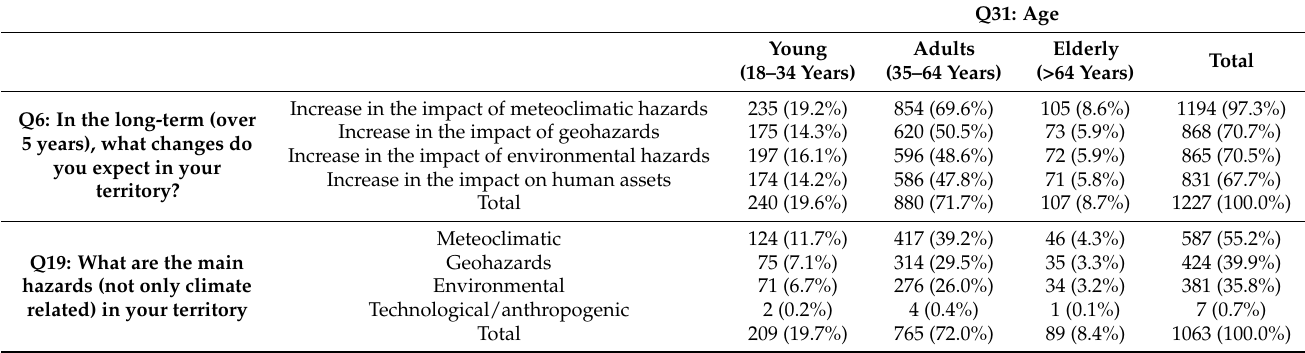
Table 6. Cross table of Q6 and Q31, and Q19 and Q31 with frequencies (percentages) of the answers.